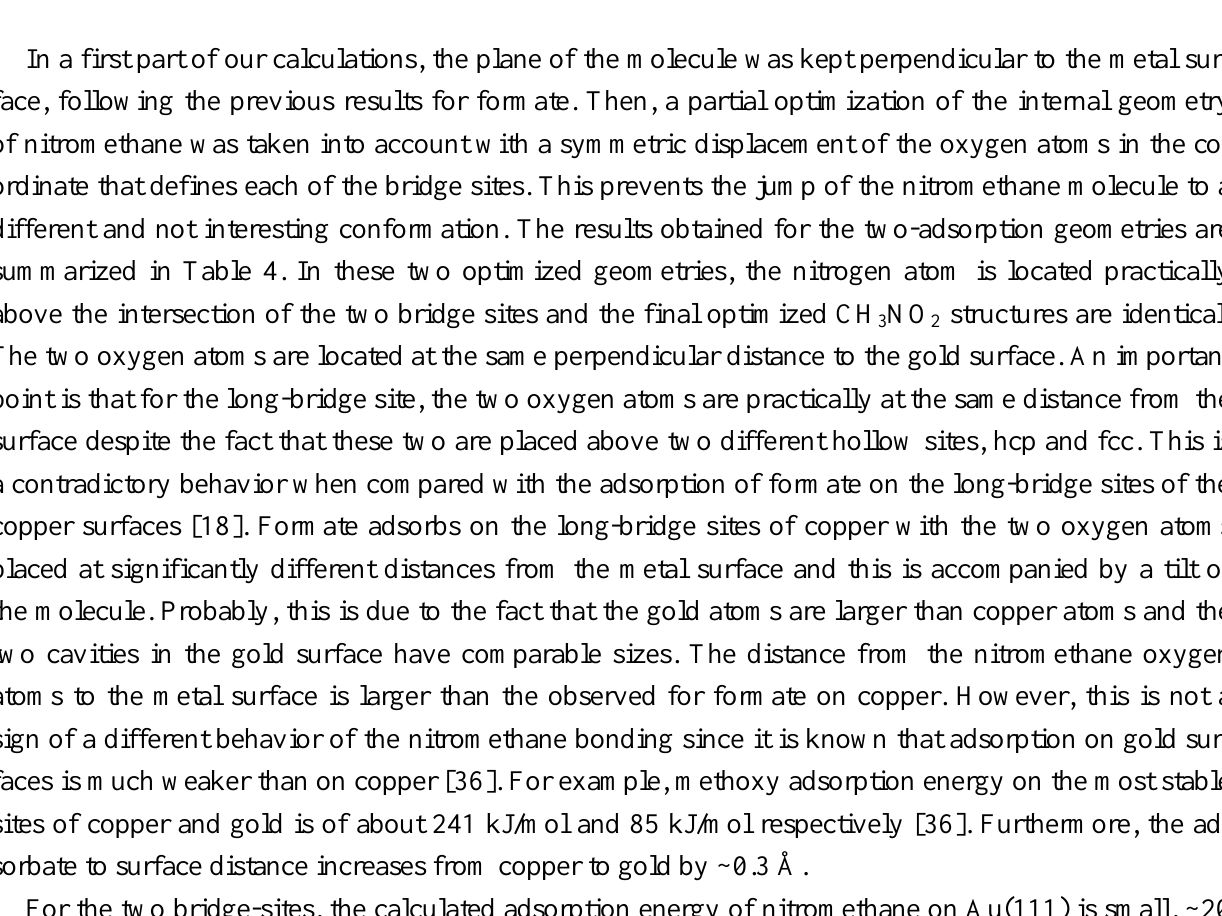
Figure 3. Starting geometries for the nitromethane molecule. Both structures are bidentate, adsorbed on a short-bridge site, left, or on a long-bridge site, right, of the Au(111)